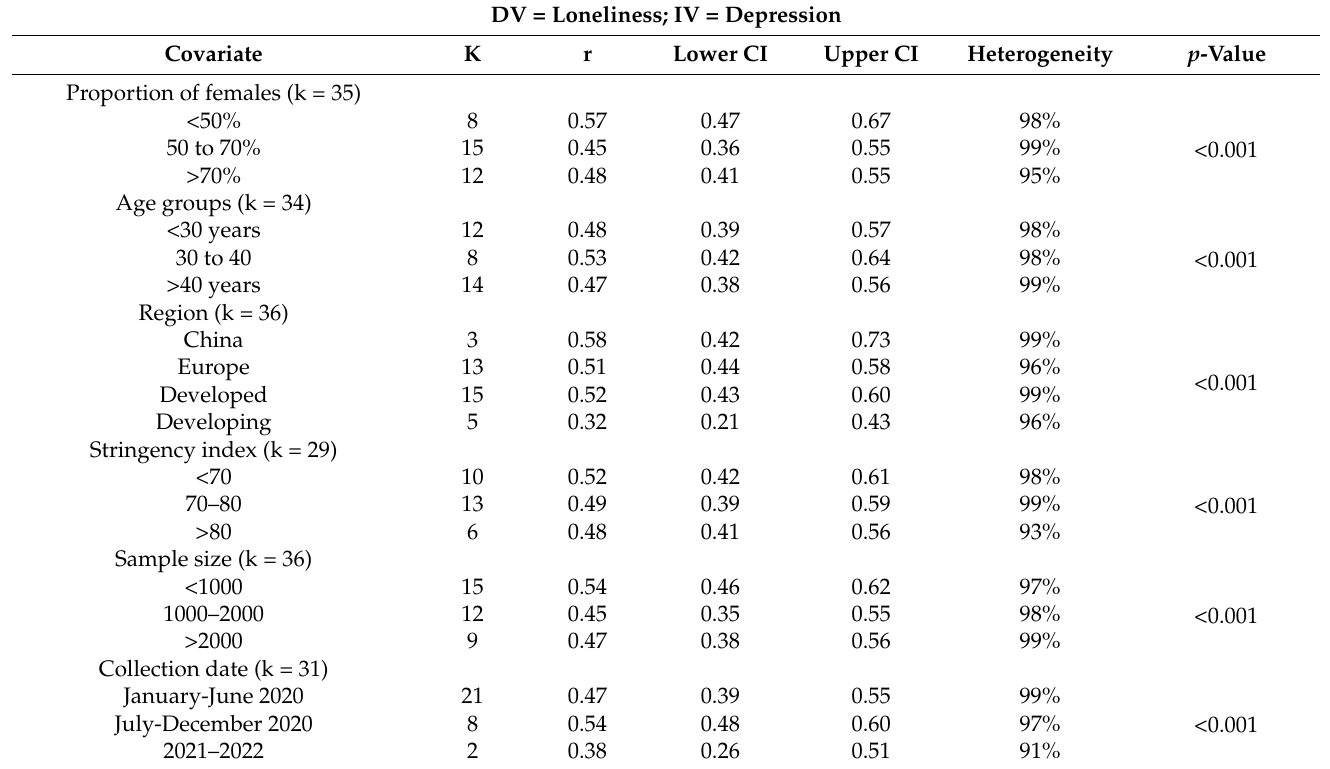
Table 2. Subgroup analysis for the associations between loneliness and mental disorder symptoms.